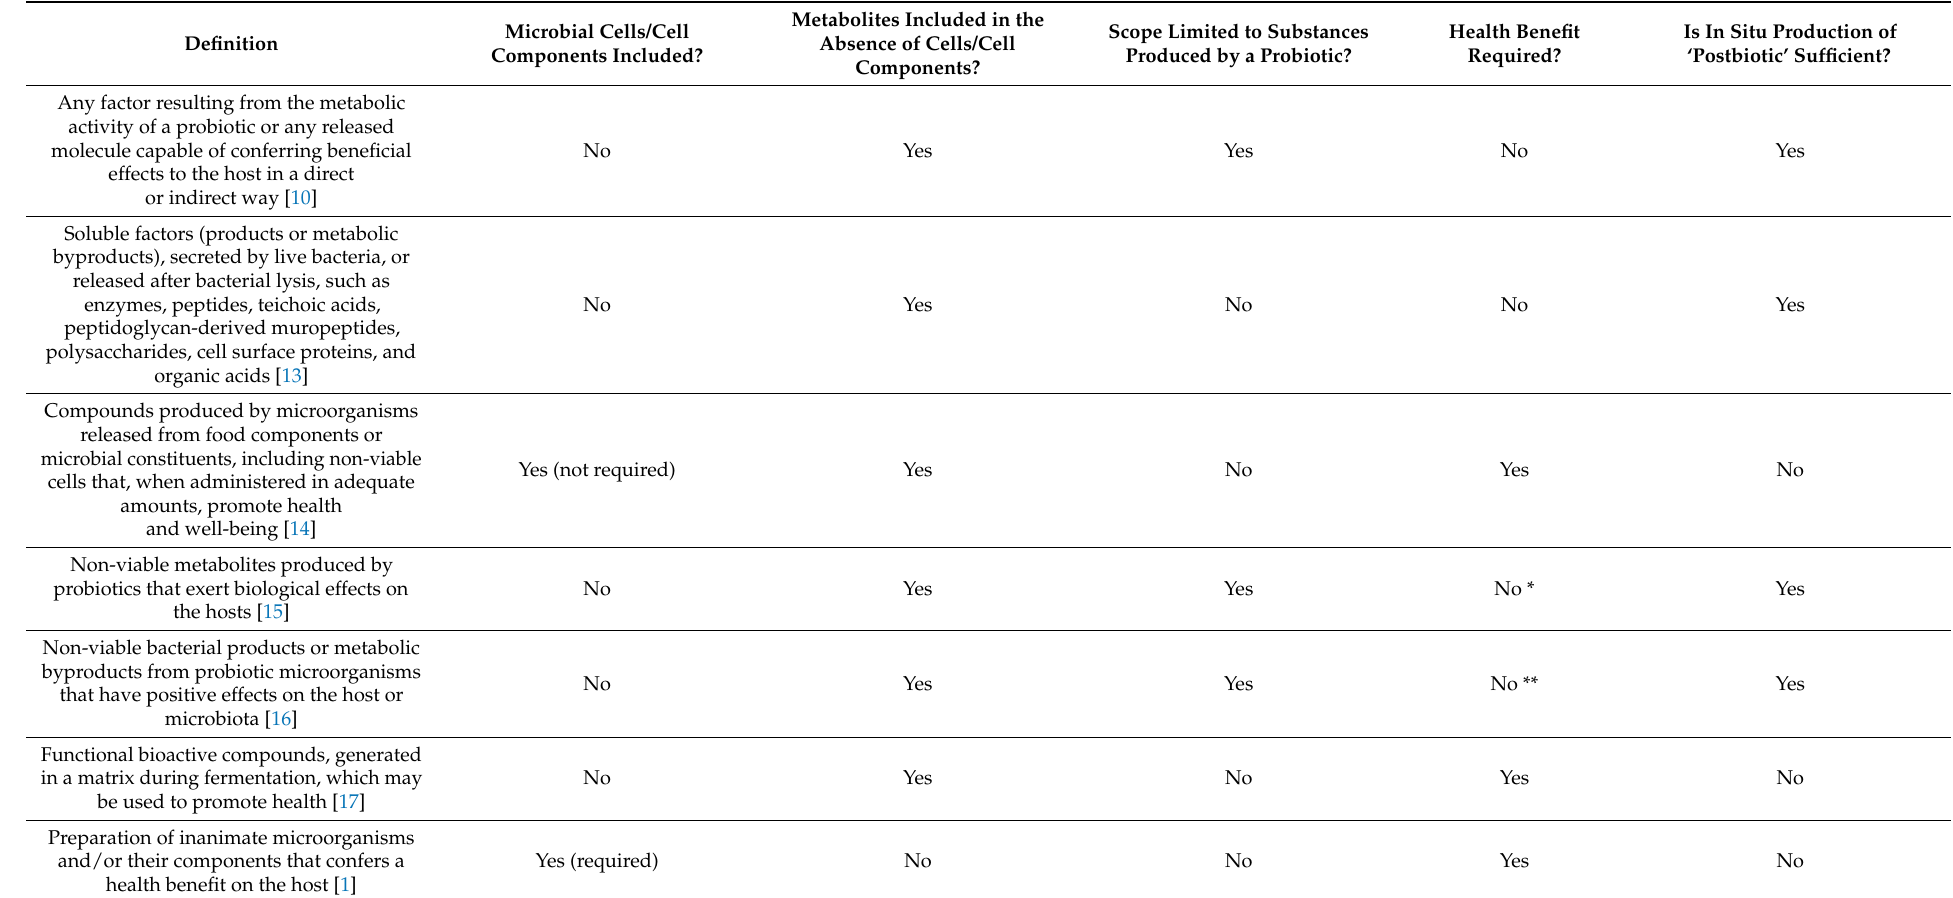
Table 2. Published definitions of postbiotics (adapted from [12], CC BY 4.0 (https://creativecommons.org/licenses/by/4.0/, accessed on 22 February